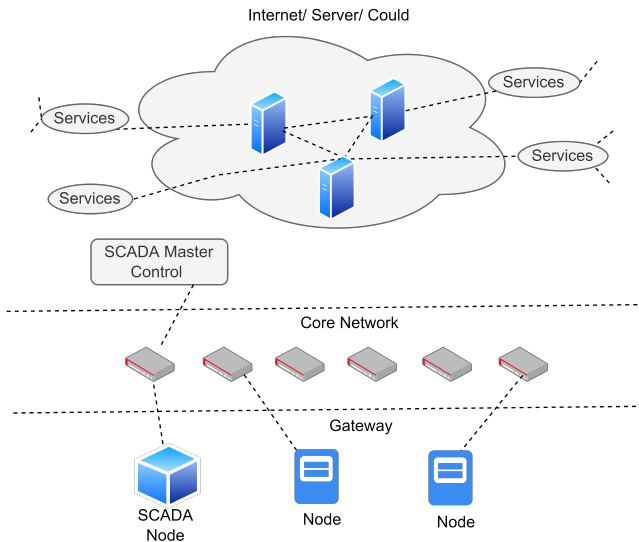
Figure 6. A representation of IIoT-based SCADA layered network